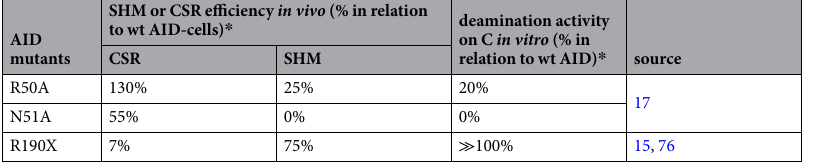
Table 1. The effect of selected mutations on AID’s ability to induce SHM and CSR in vivo and to deaminate C in vitro . * Approximate values are